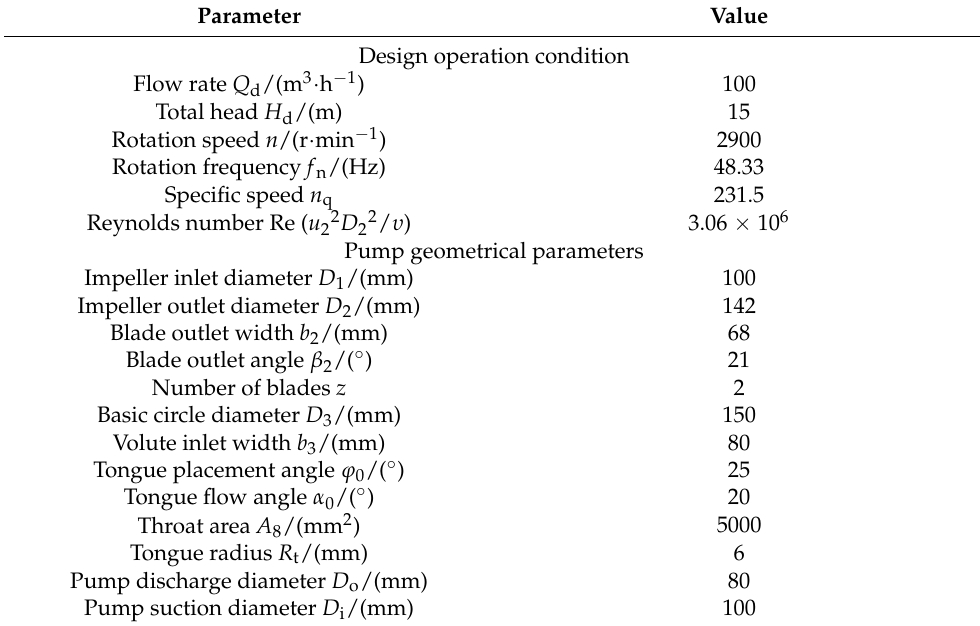
Table 1. Main data of the